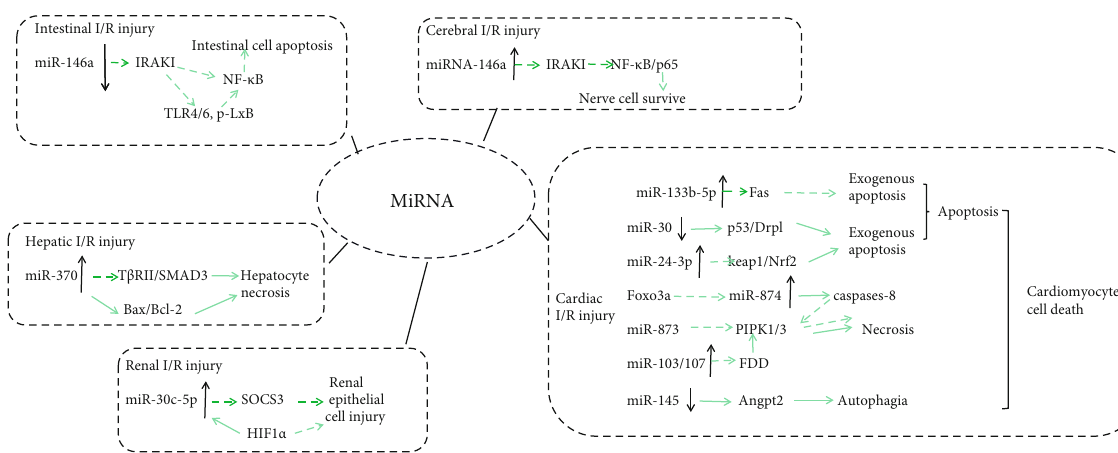
Figure 2: miRNAs in cerebral, intestinal, hepatic, cardiac, and renal I/R injury. Solid arrow indicates promote. Dotted arrow indicates